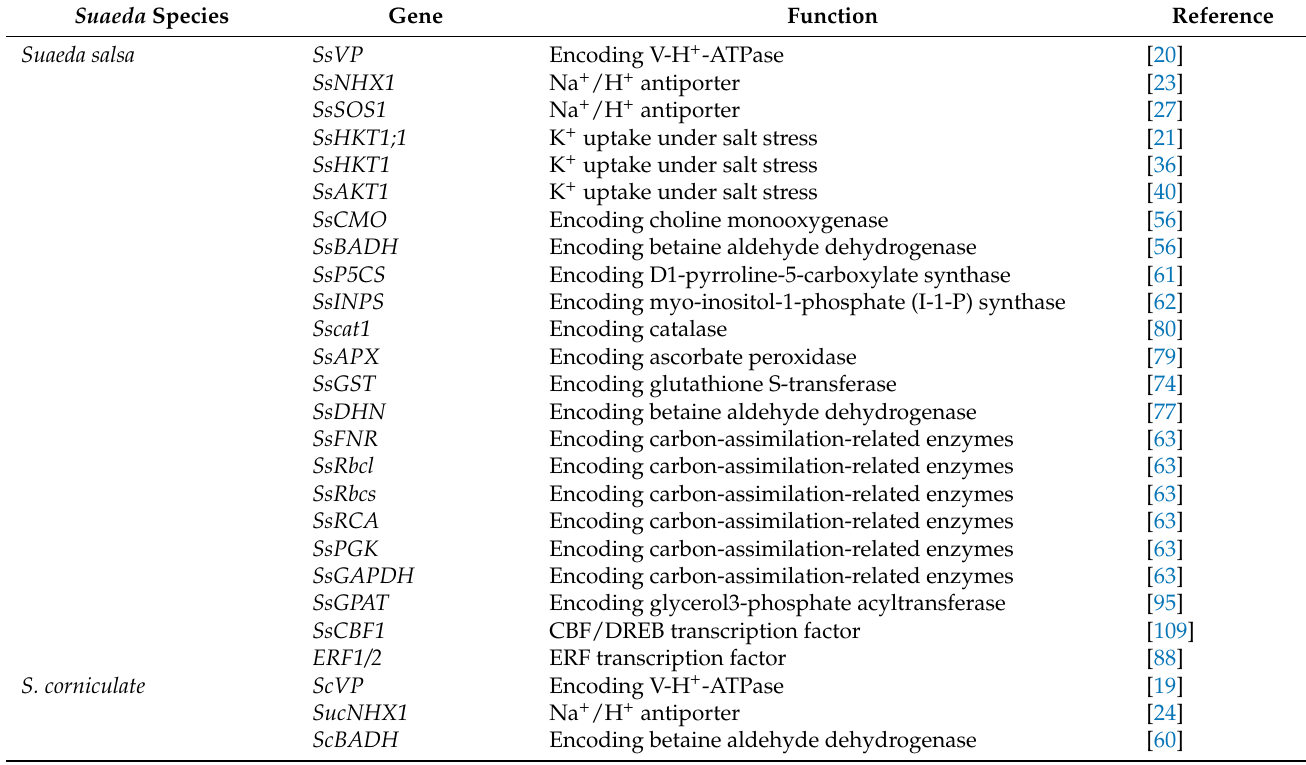
Table 1. The genes in Suaeda species and their probable